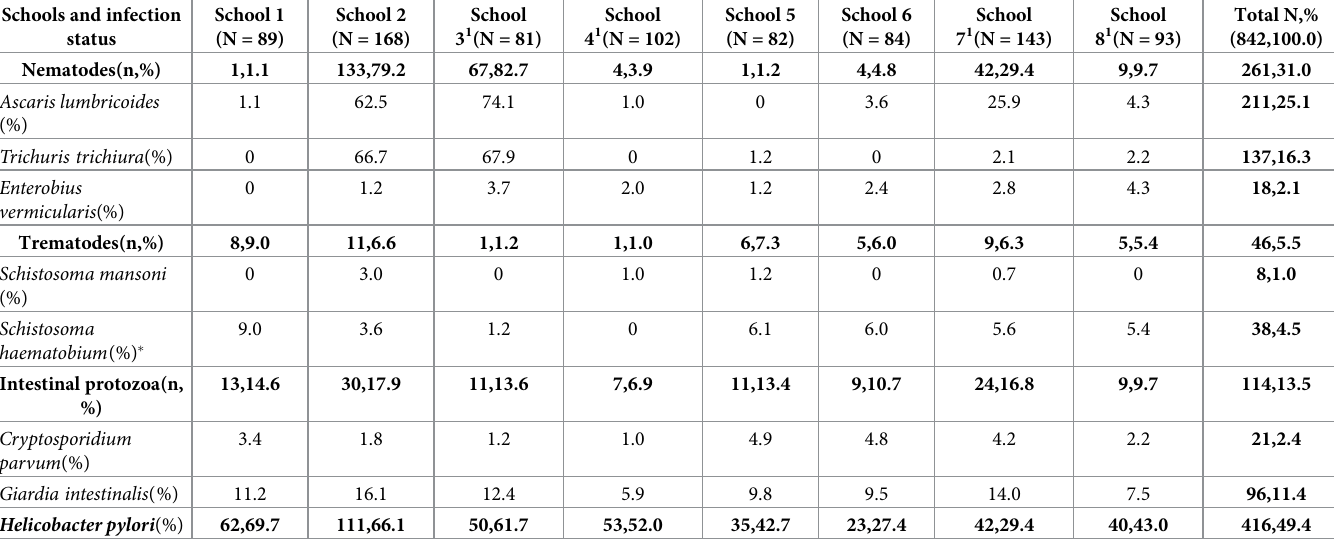
Table 1. Baseline prevalence (%) of gastrointestinal tract infections, stratified by